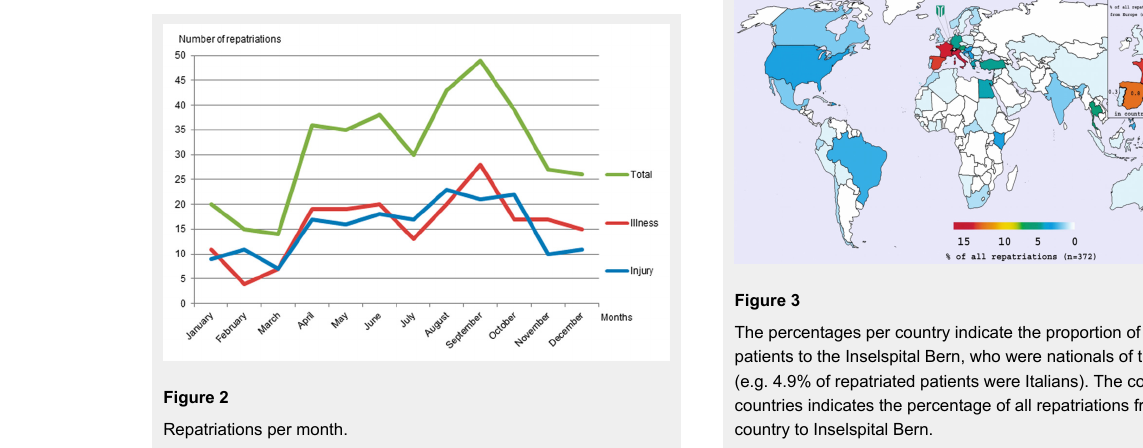
Table 1: Nationality of repatriated patients.